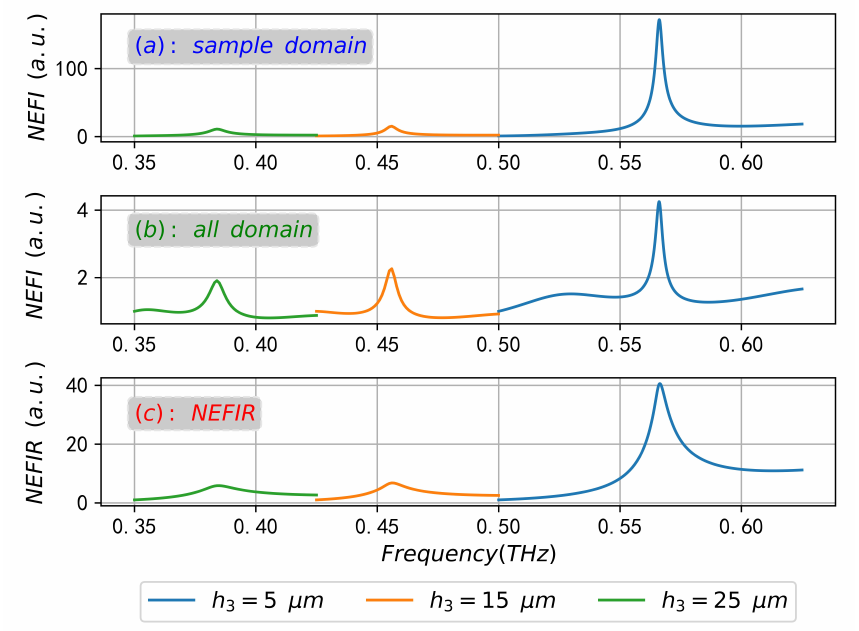
Figure 12. The NEFI for sample area ( a ) and all computational domains ( b ), and the NEFIR ( c ).